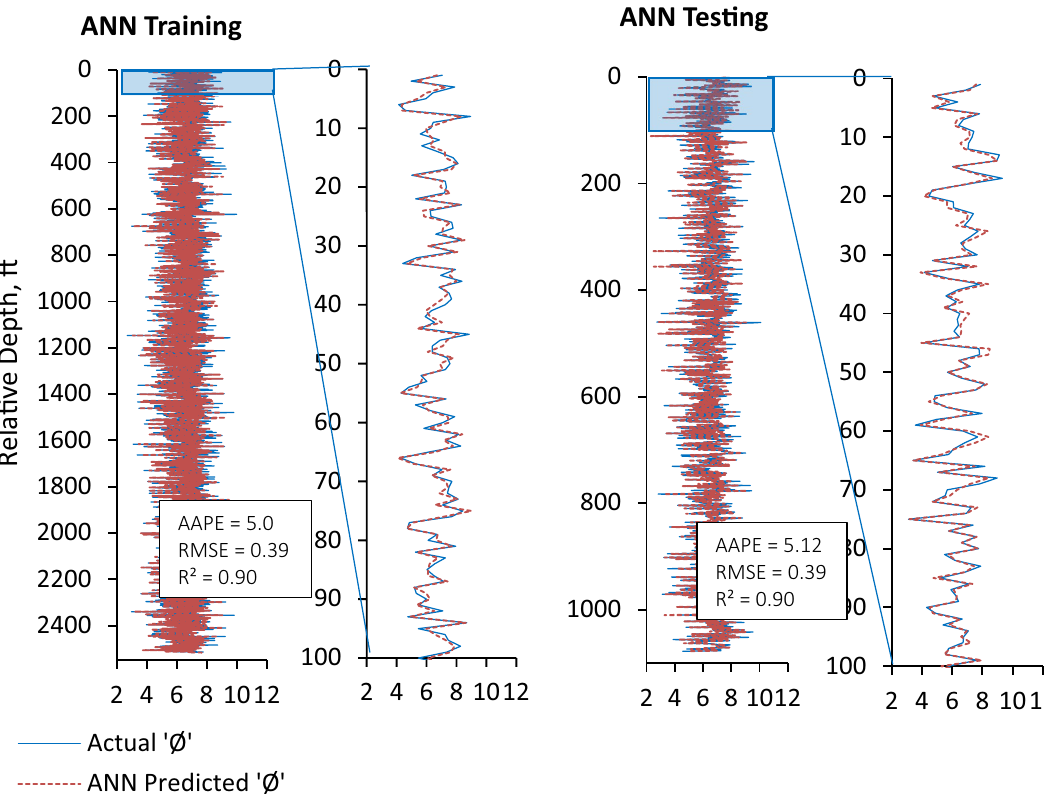
Figure 10. Comparison of training and testing results of ANN model with actual Φ NMR .